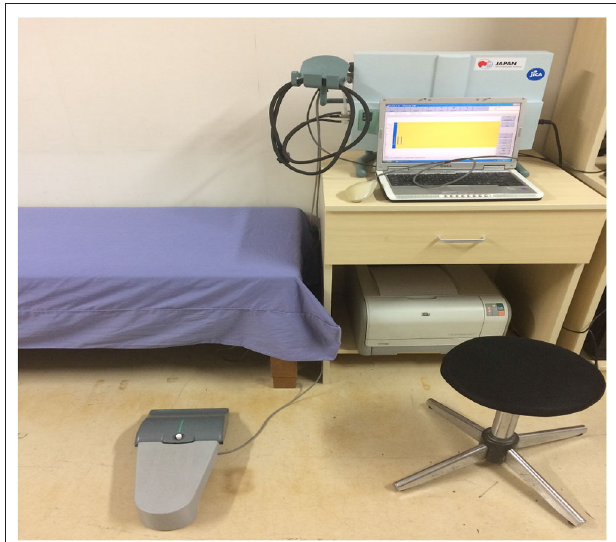
FIGURE 4 | VSA-3000 (Medoc, Israel).